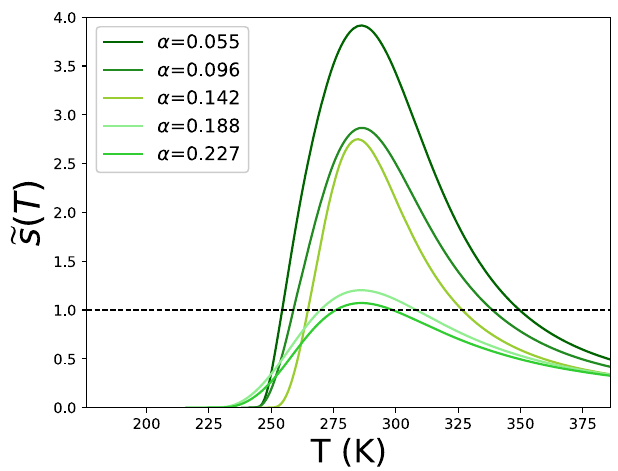
Fig. 4 Stability parameter of Zimm – Bragg model with fi tted parameters inserted. Temperature dependence of renormalized stability parameter e s from Eq. (3); color code of α ¼ h ps (cid:2) h h and other values as in Fig. 3d and Table